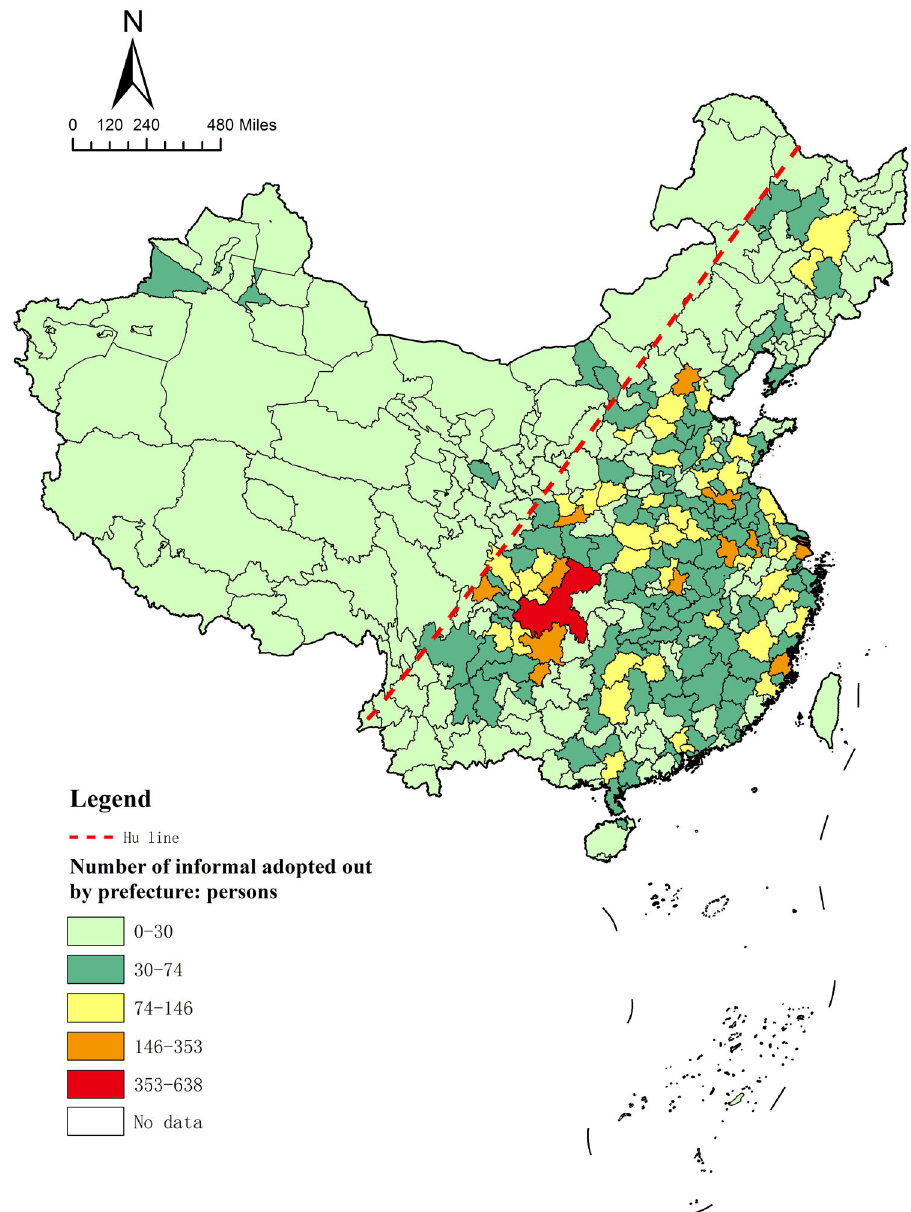
Fig. 5 Geographical distribution of informal out-adoptions for each city. Red indicates the largest number of children adopted out of these cities, followed by orange, yellow, dark green, and light green. White indicates that the data are insuf fi cient for this province. The red dotted line is the dividing line of the population density in China, which is called the Hu